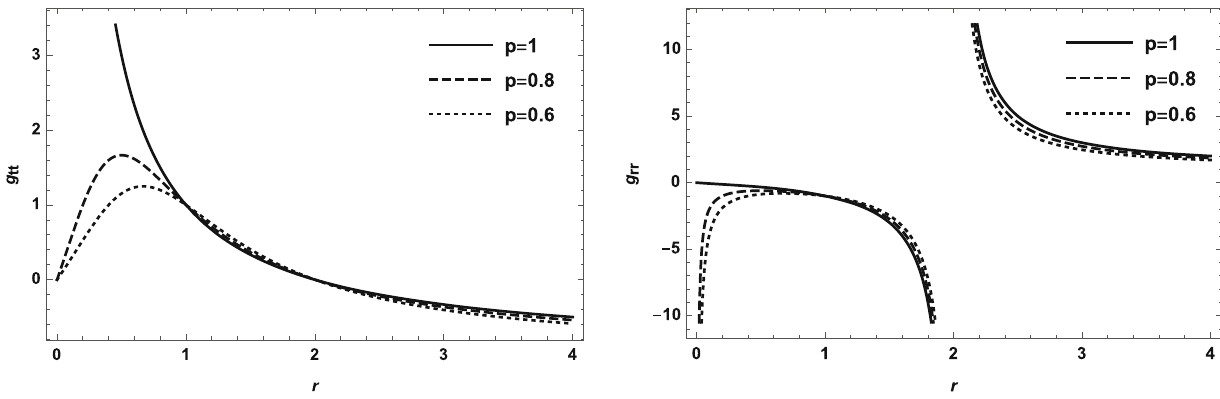
Fig. 1 The radial dependence of the metric components g tt (left panel) and g rr (right panel) for fixed value of the mass parameter m , in the NUT space-time (i.e. for γ = 1) with line element (25) and different values of the ‘quasi-NUT’ parameter q